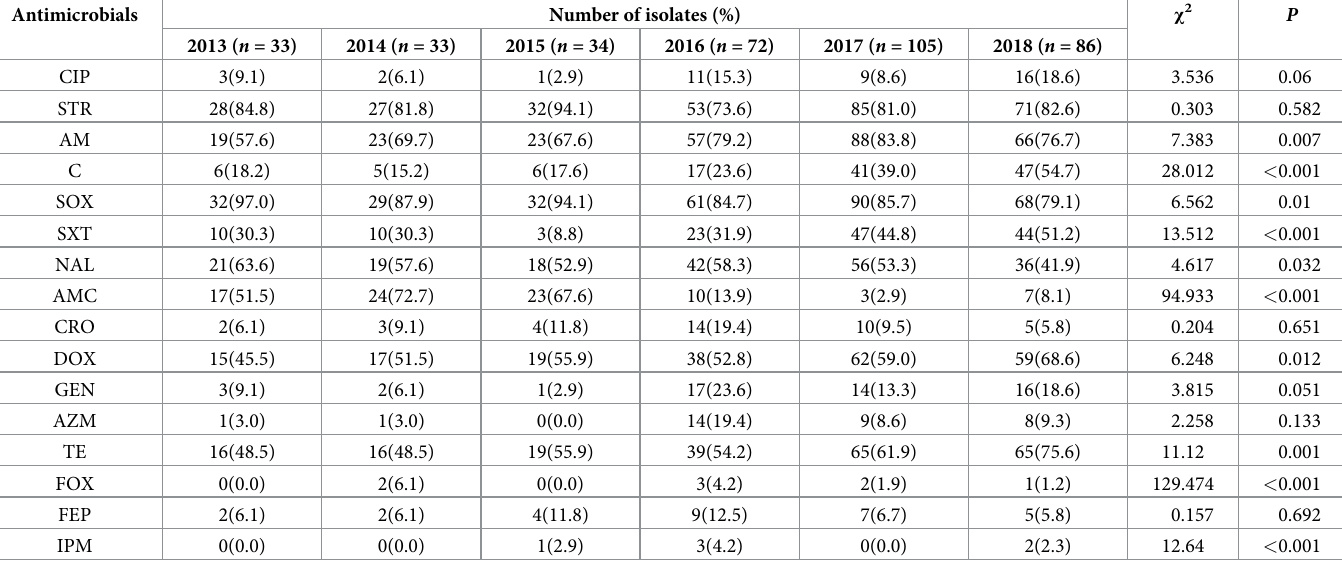
Table 3. Antimicrobial resistance of Salmonella isolates in Guizhou from 2013 to 2018.